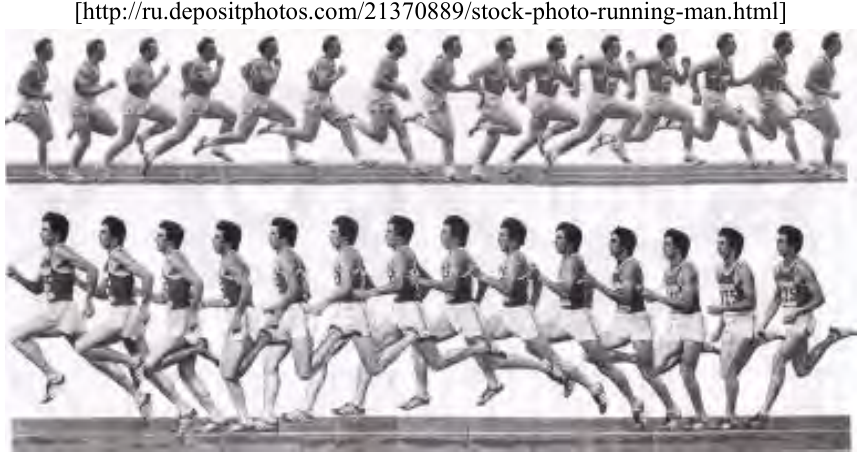
Fig. 2. Video gram of run technique of elite